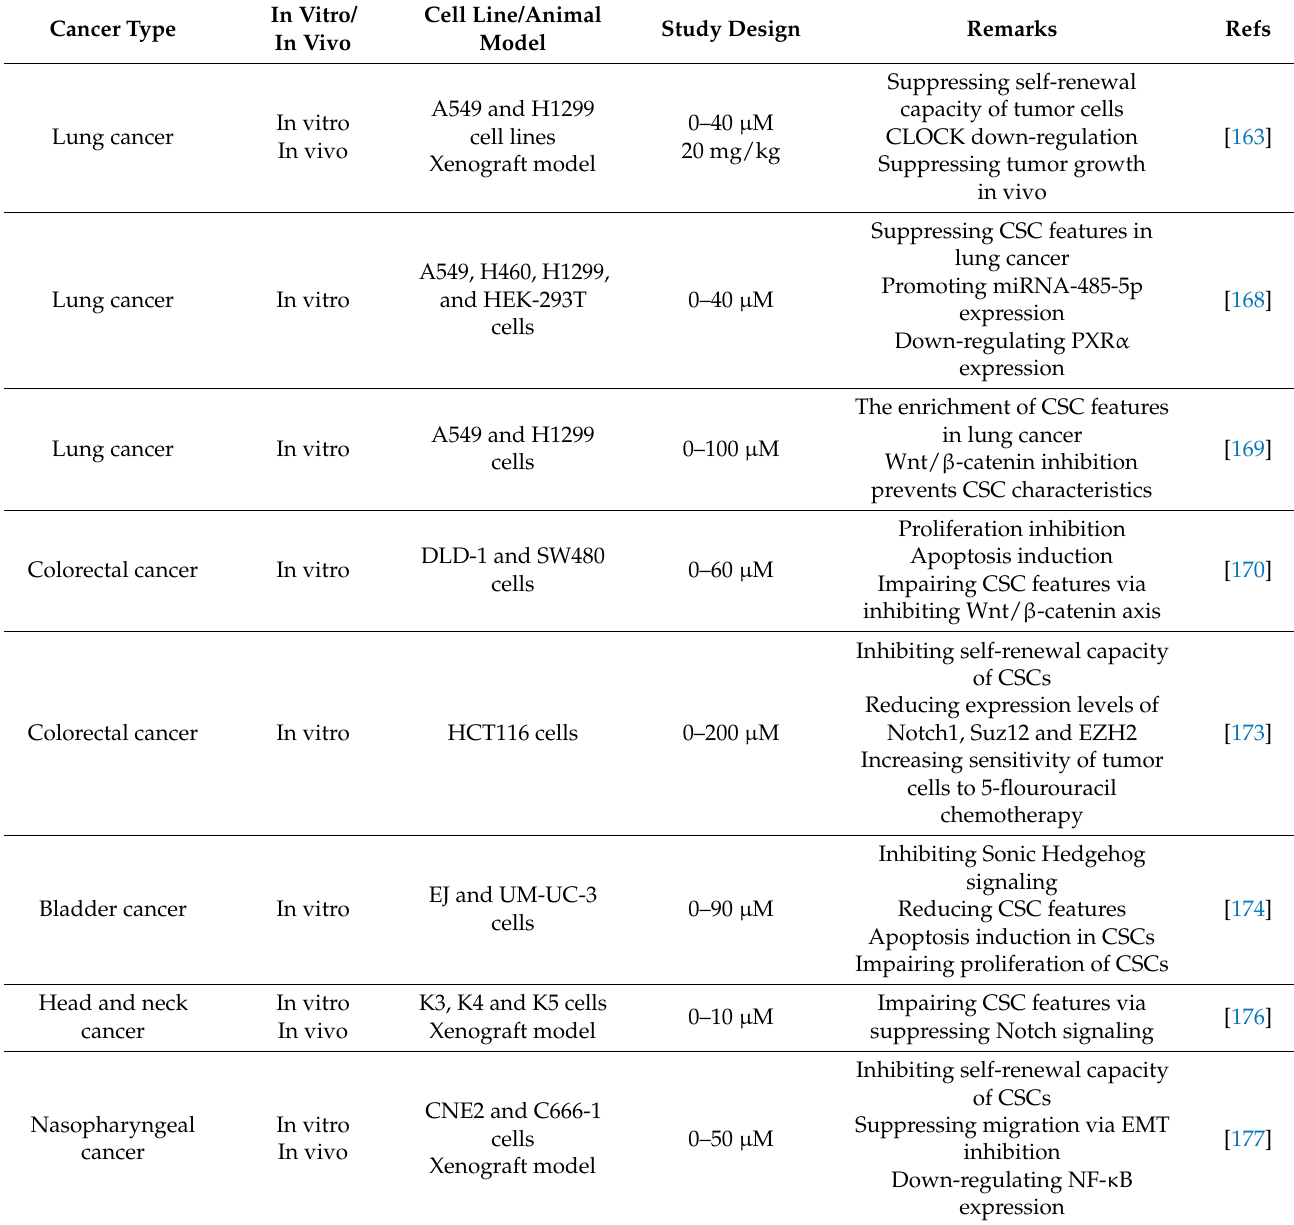
Table 2. Gallate in suppressing